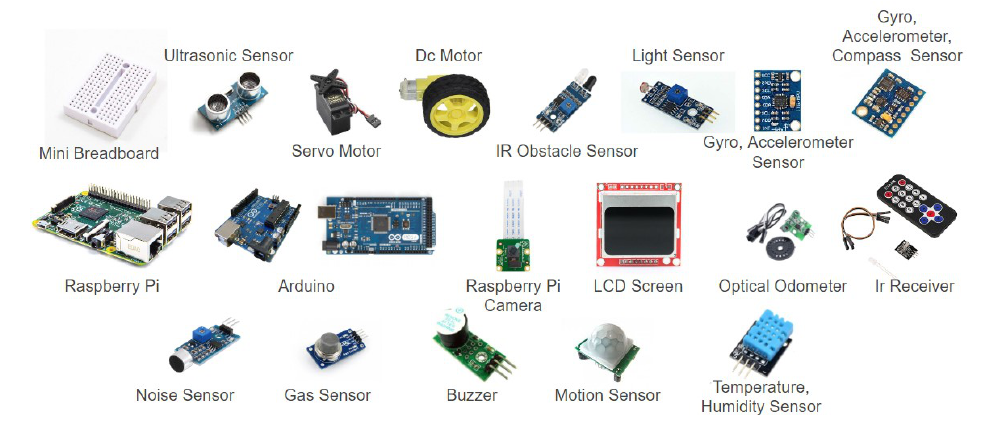
Figure 2. The suite of FOSSBot electronics.